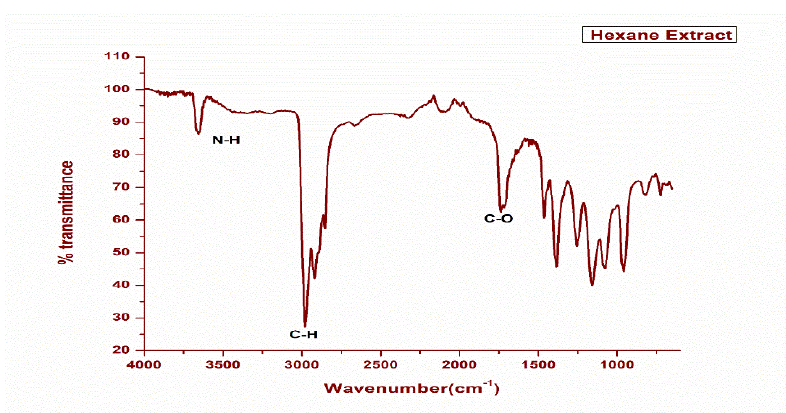
Figure 2. FTIR spectral analysis of hexane extract of plant Nymphaea Mexicana Zucc.